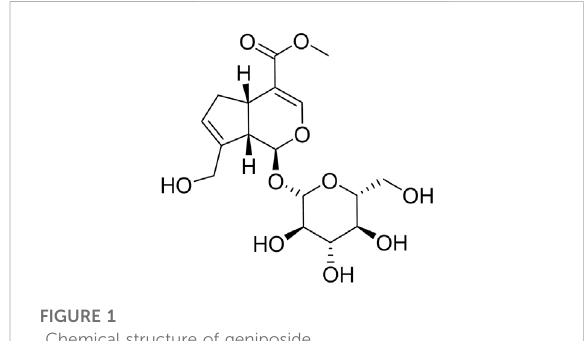
FIGURE 1 Chemical structure of